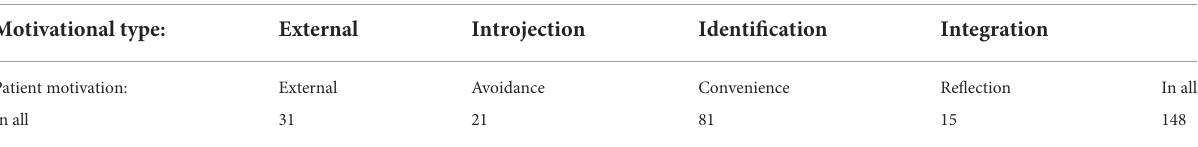
TABLE 5 Distribution of patients’ motivational types regarding online